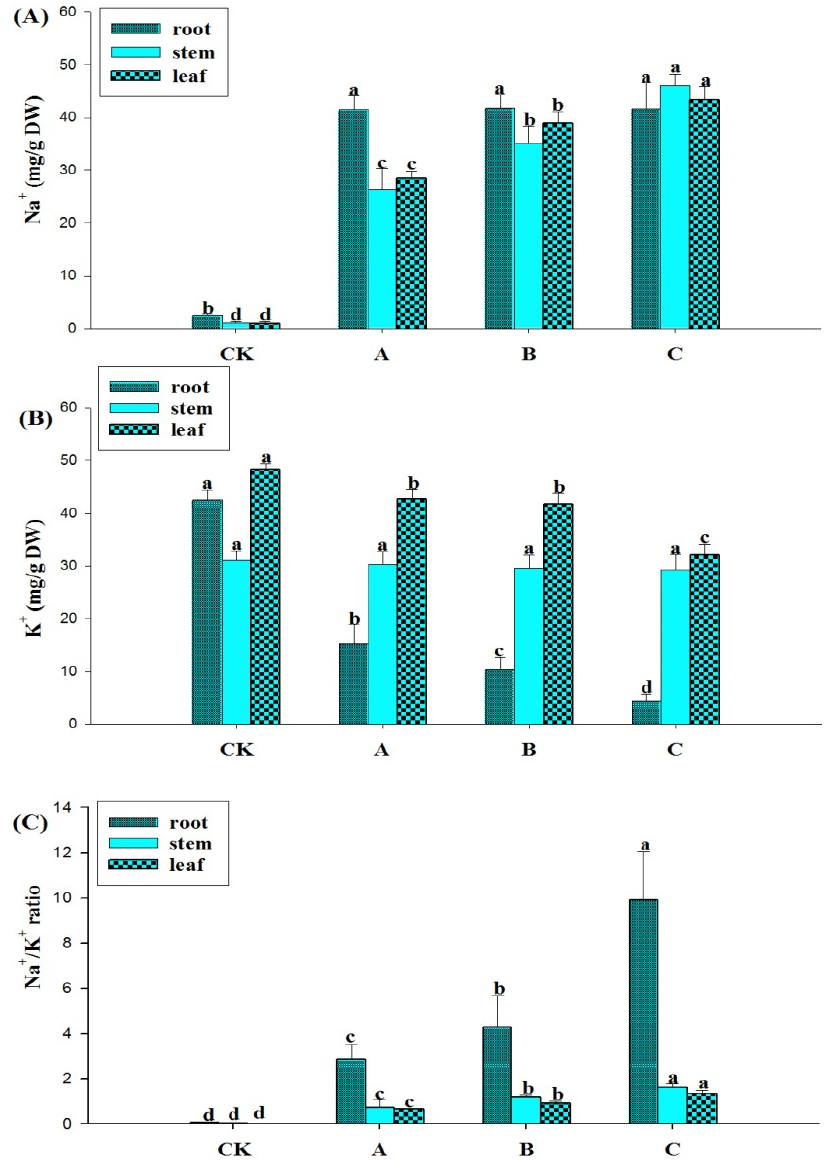
Figure 4. Effects of salinity and alkalinity stress on ( A ) Na + content, ( B ) K + content, and ( C ) Na + /K + in the roots, stems, and leaves of wheat seedlings. The bars represent the standard errors (±SE) of the four replicates. Different letters on the column represent significant difference among treatments ( p ≤ 0.05); the letters mainly show a comparison of roots, stems, and leaves among different treatments.